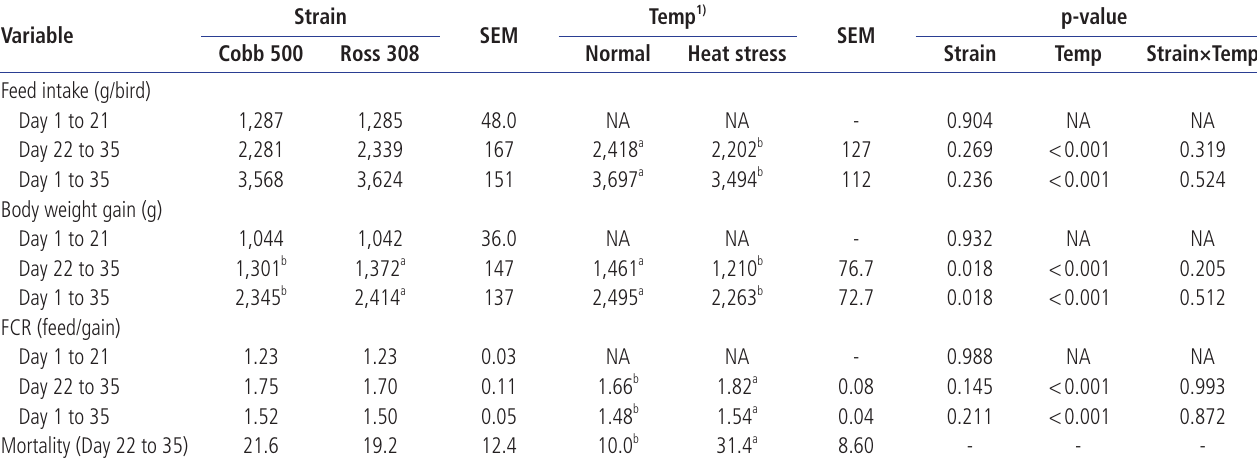
Table 2. Effects of strain and temperature on feed intakes, body weights, feed conversion ratios, and mortality rate in broiler chickens from 1 to 35 days of age Strain Temp 1) p-value Variable SEM SEM Cobb 500 Ross 308 Normal Heat stress Strain Feed intake (g/bird) Day 1 to 21